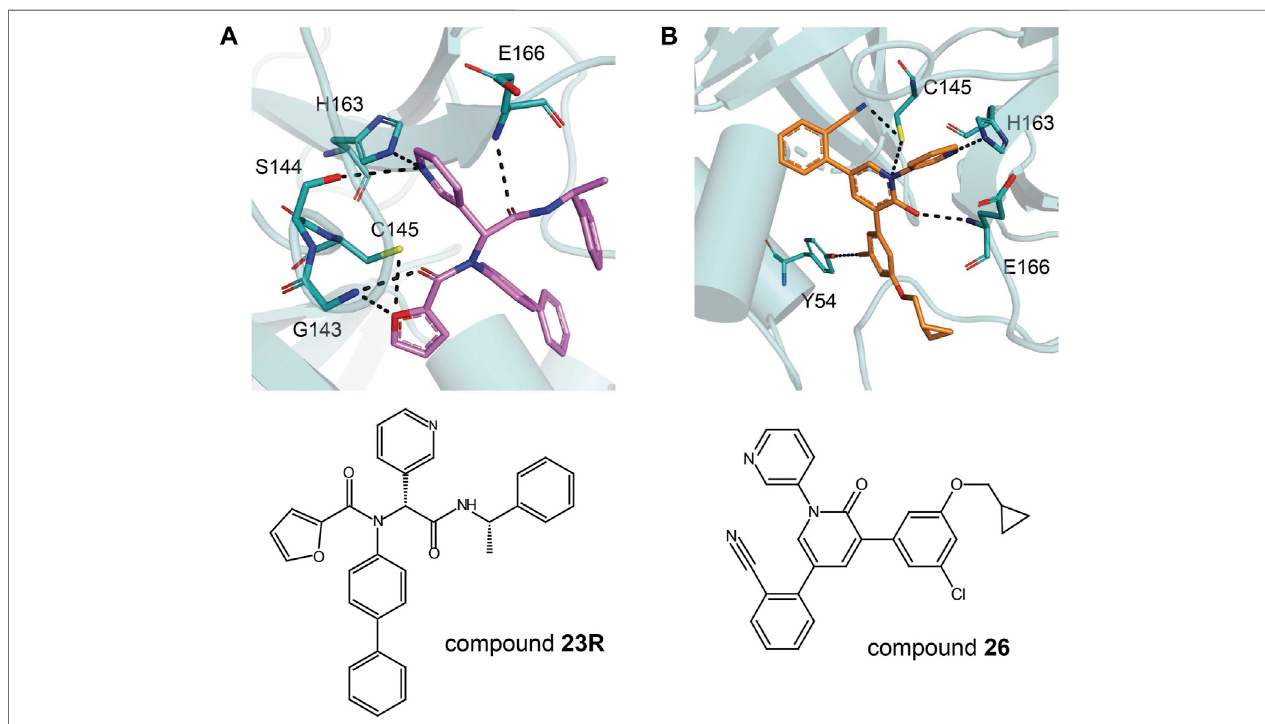
FIGURE 15 | Close-up view of the interactions between SARS-CoV-2 Mpro with ML188 derivative 23R and perampanel derivative 26. Close-up view of the interactionsbetweenSARS-CoV-2Mproandinhibitorsincrystalstructures.Mproisshownascartoonrepresentation,withresiduesinvolvedintheinteractionshownas sticks. Inhibitors are shown as violet sticks. Hydrogen bonds were labeled with dashed lines. (A) Compound 23R (PDB: 7KX5), violet. (B) Compound 26 (PDB: 7L14),